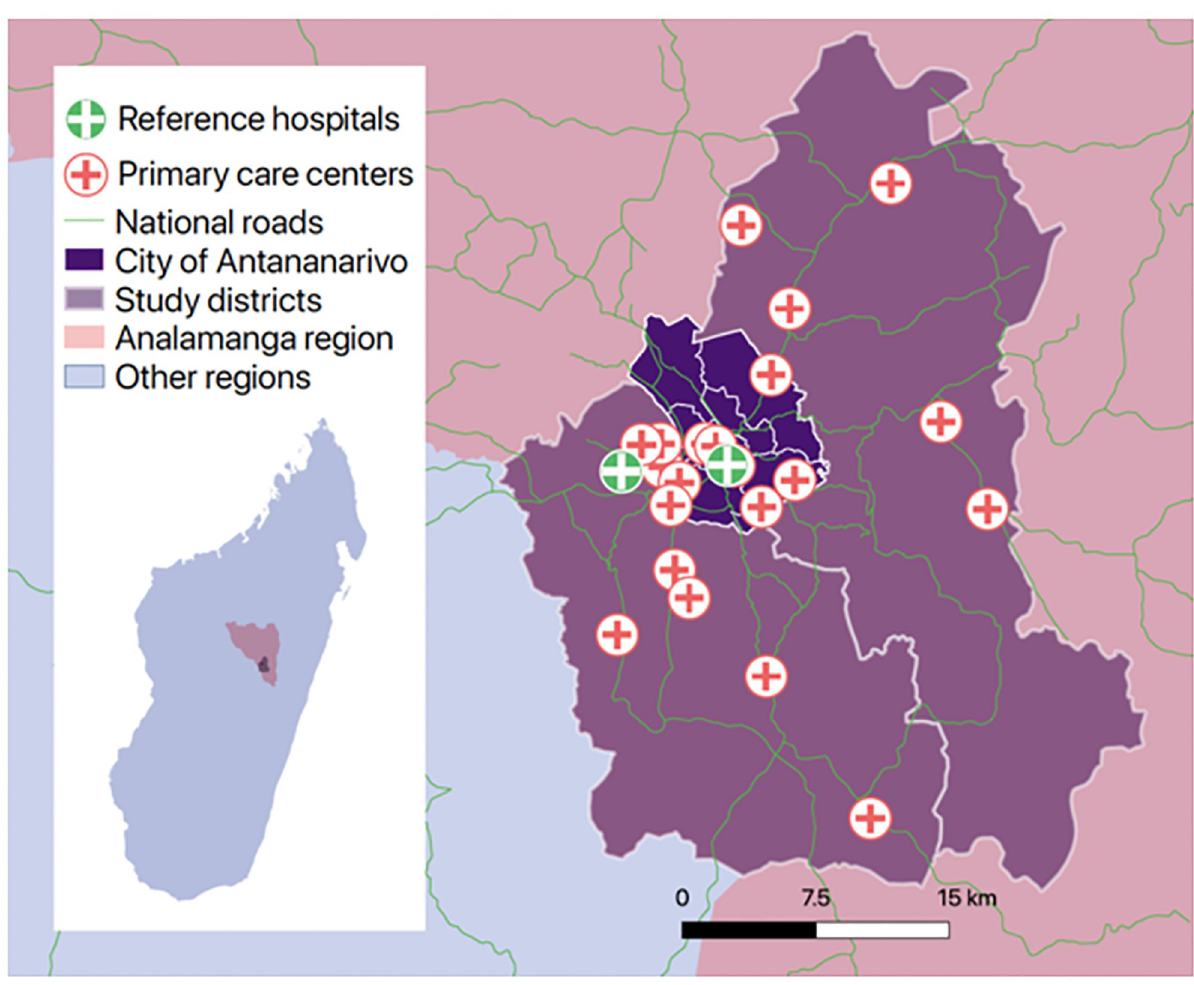
Fig 1. Map depicting the study area of the Mobile Maternal Health Wallet intervention in Analamanga,